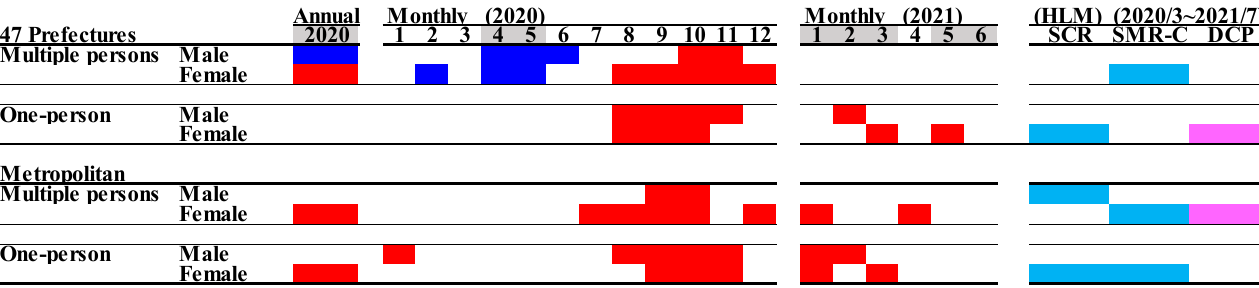
Figure 7. Comparison of annual and monthly SMR-S disaggregated by household condition during the pandemic period to average SMR-S of the same month during the pre-pandemic period, and impact of COVID-19 pandemic on SMR-S in Japan. Blue and red columns indicate significant decreasing and increasing suicide mortality using a linear mixed-effects model with Tukey’s multiple comparison ( p < 0.05). Light blue and red columns indicate significant decreasing and increasing factors against SMR-S using hierarchical linear model with robust standard error ( p < 0.05). SMR-S: standardised suicide mortality per 100,000 people. SCR: standardised infection with COVID-19 per 100,000 people. SMR-C: standardised mortality caused by COVID-19 per 100,000 people. DCP: during COVID-19 pandemic.